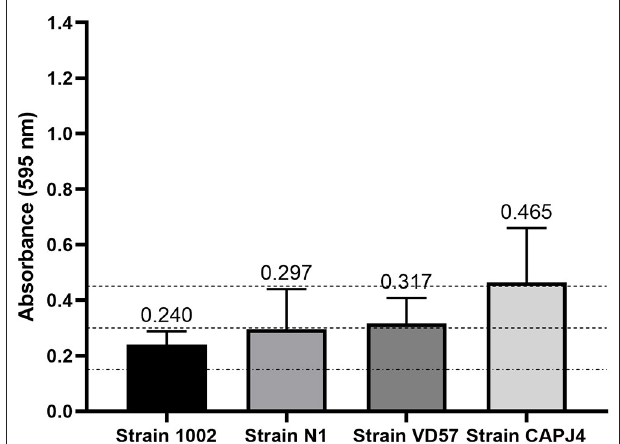
FIGURE 1 | Semi-quantification of biofilm production by C. pseudotuberculosis reference strains. The dashed lines indicate the mean value of the negative control (DO595 < 0.150), weak biofilm production (DO595 between 0.150 and 0.300), moderate biofilm production (DO595 between 0.300 and 0.450), and strong biofilm production (DO595 > 0.450). The bars indicate the standard deviation of three independent experiments, each one made with three